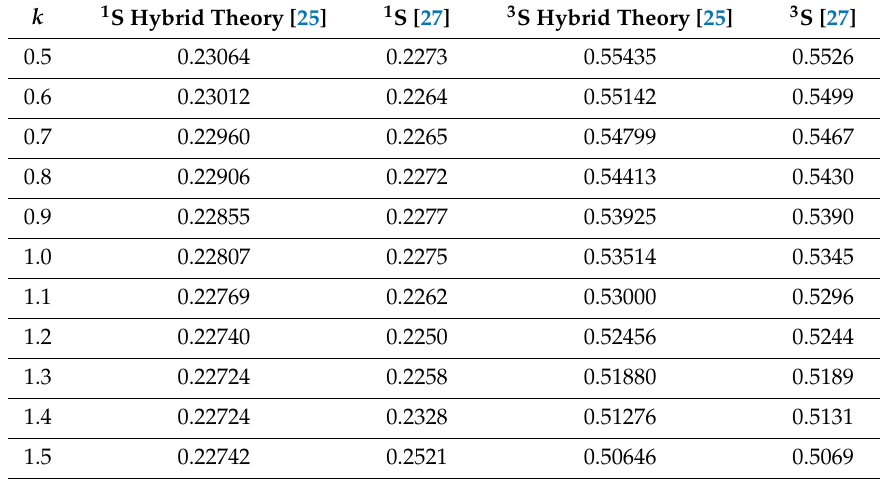
Table 5. Comparison of the 1 S and 3 S calculated phase shifts (radians) for electron—Li 2 + scattering [25] with those obtained by Gien [27] using the Harris–Nesbet